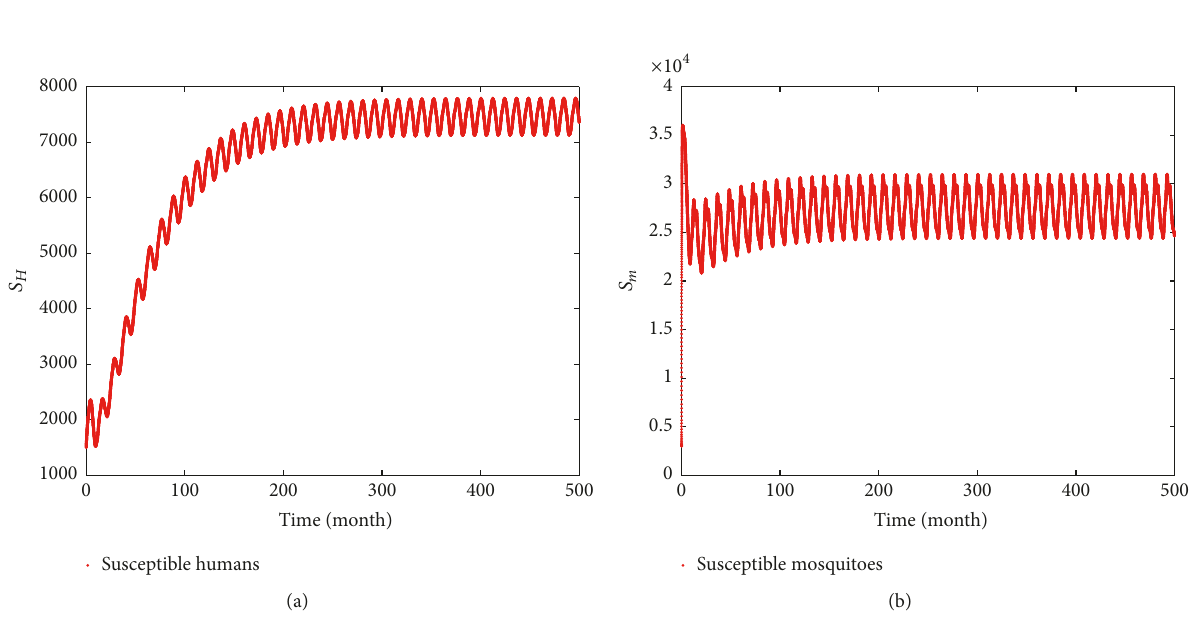
Figure 3: Distribution of infected mosquitoes.